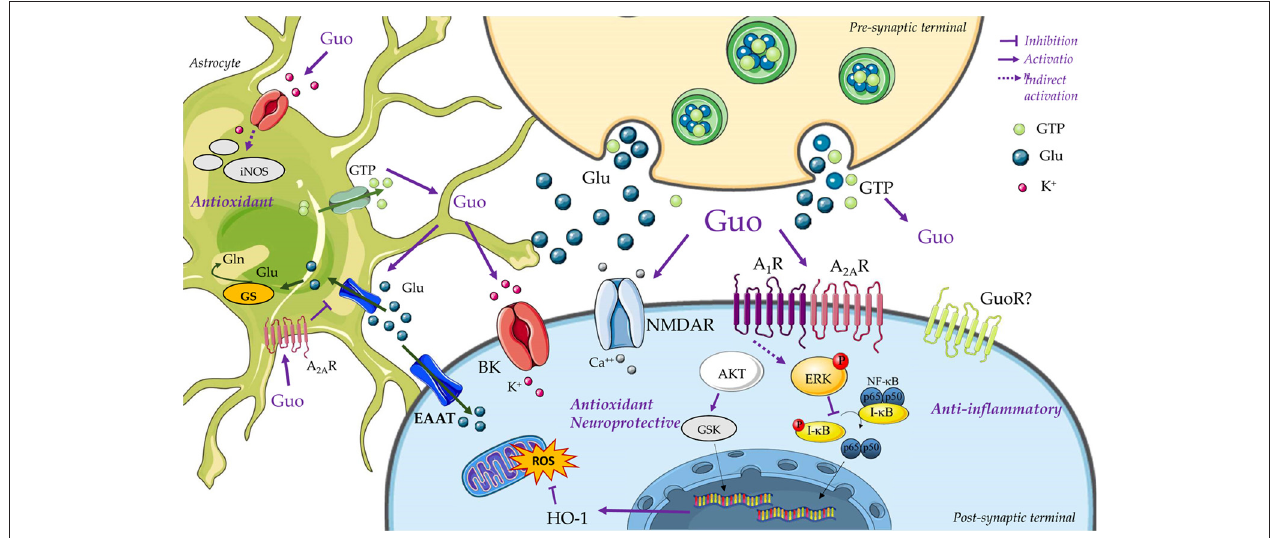
FIGURE 2 | Guanine-based purinergic signaling. This cartoon presents an overview of the main mechanisms involved in the neuroprotective effects of guanosine. The release of guanine nucleotides (i.e., GTP) from synaptic vesicles or astrocytes produces extracellular guanosine (Guo) following hydrolysis by ecto-nucleotidases. Guanine may also be formed by PNP activity on guanosine (not represented). A specific binding site for Guo has not been disclosed yet (i.e., guanosine receptor, GuoR), but guanosine effects through calcium-dependent (big) conductance potassium (BK) channels, A 1 R and A 2A R adenosine receptors, and glutamatergic N-methyl-D-aspartate receptors (NMDARs) has been described. Guanosine promotes neuroprotection through an anti-inflammatory effect of inhibiting nuclear factor kappa B (NF- κ B) activation via MAPK/ERK. Additionally, guanosine presents antioxidant effects, as reducing the reactive oxygen species (ROS) generation, preventing inducible nitric oxide synthase (iNOS) expression, and by increasing antioxidant defenses, as Heme-oxygenase-1 (HO-1) levels. Activation of PI3K/Akt, protein kinase C (PKC) and MAPK/ERK by guanosine leads to stimulation of excitatory amino acid transporters (EAATs) activity. Guo also increases glutamine (Gln) synthetase (GS) activity, thus reducing extracellular levels of glutamate (Glu) and protecting from glutamate excitotoxicity. Figure designed using image templates from Servier Medical Art